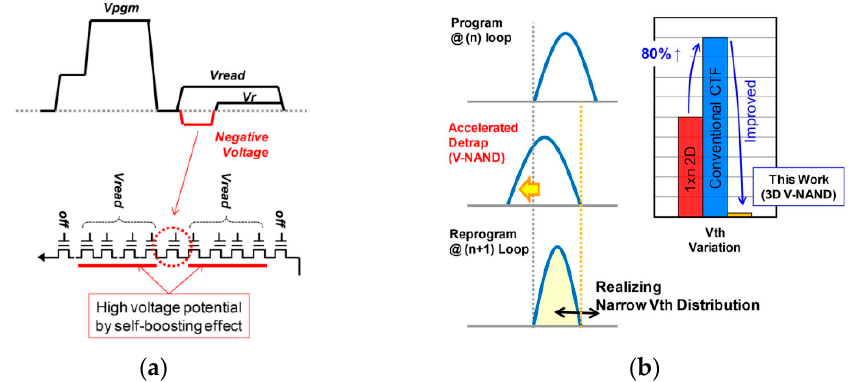
Figure 7. ( a ) Negative counter-pulse scheme. Reprinted/adapted with permission from Ref. [48], 2015, IEEE. ( b ) Diagram of its mechanism and measured Vt variation. Reprinted/adapted with permission from Ref. [48], 2015,